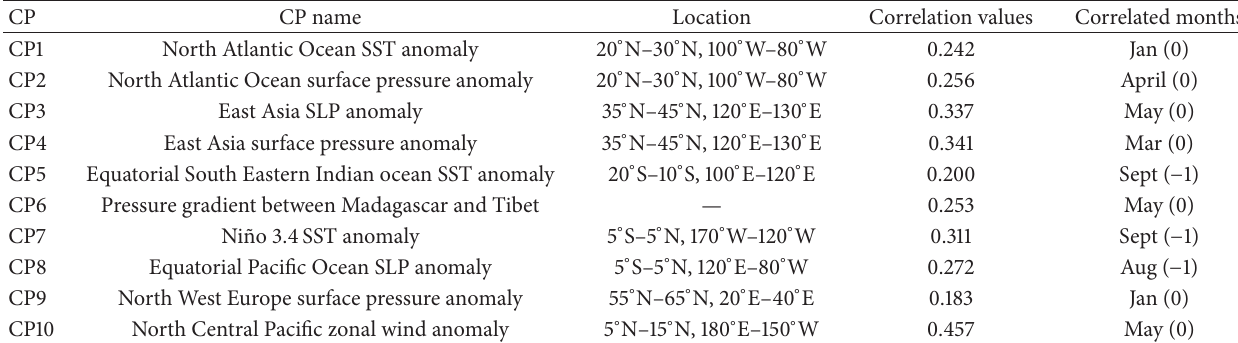
Table 1: Climatic parameters (CP) influencing Indian monsoon with geographical location, correlation values, and correlated month (0 signifies same years and − 1 signifies previous year).